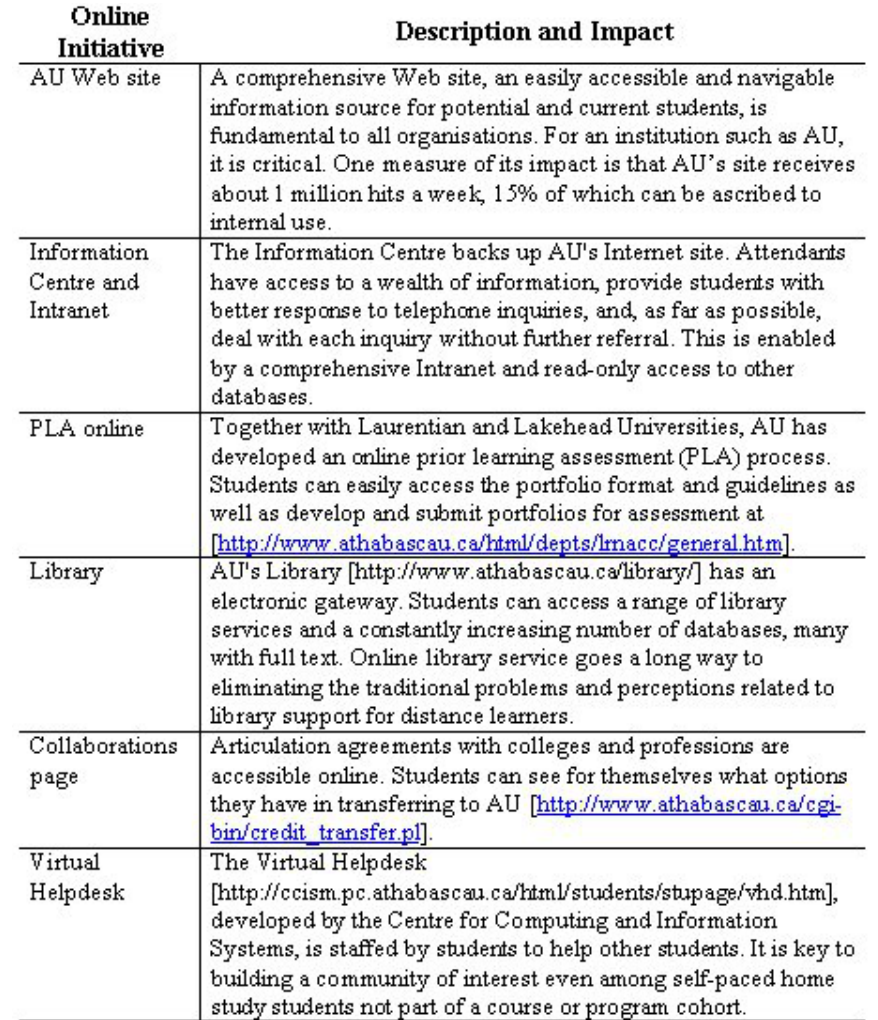
Table 1: Impact on learners of some online initiatives at